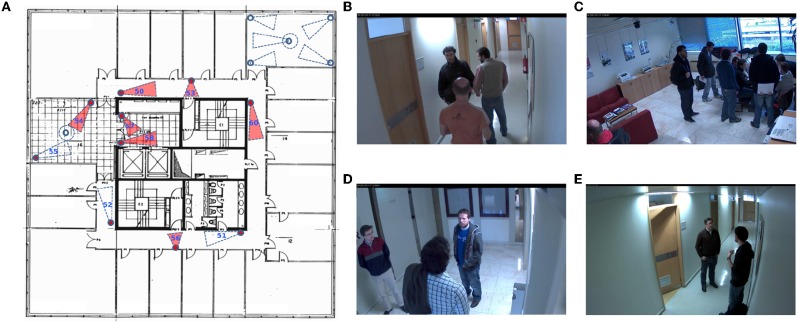
Illustration of public HDA dataset (Nambiar et al., 2014). (A) Camera layout; (B) Camera 50; (C) Camera 54; (D) Camera 58; (E) Camera 60.